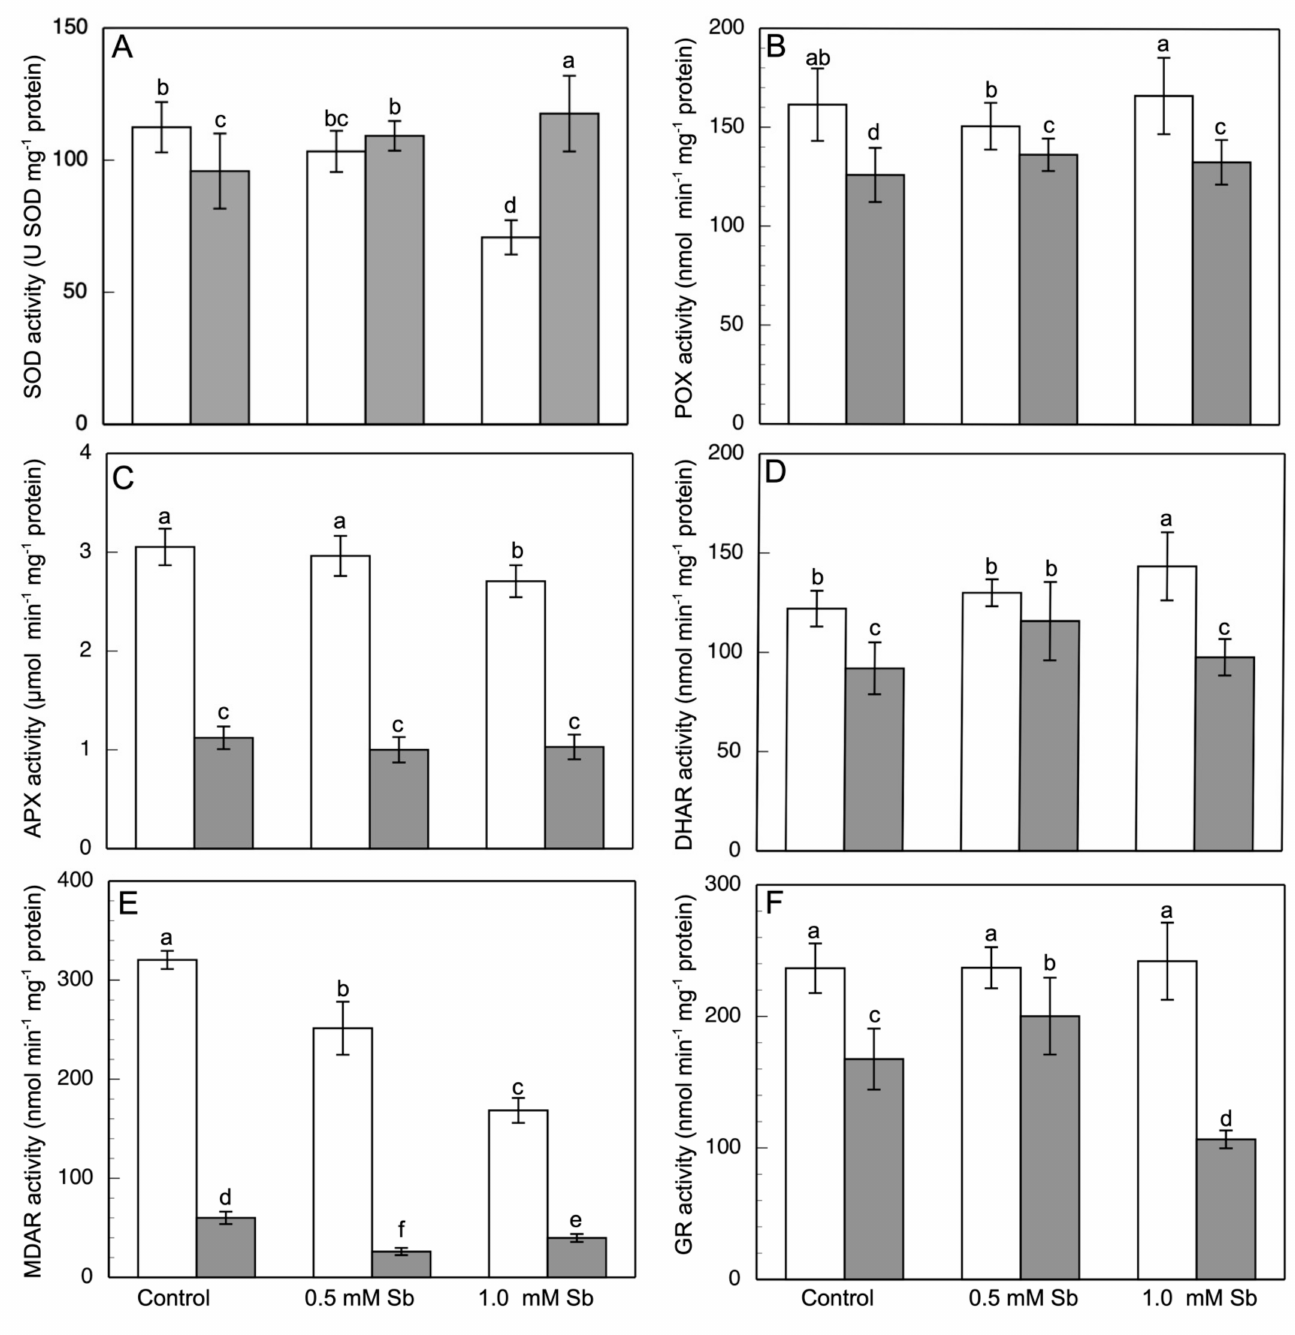
Figure 4. Effect of Sb on the SOD ( A ), POX ( B ), APX ( C ), DHAR ( D ), MDAR ( E ) and GR ( F ) activities, in roots (white) and leaves (gray) of D. viscosa . The data are from 10 independent experiments, each carried out in triplicate (different letters indicate significant differences at p < 0.05, Mann–Whitney